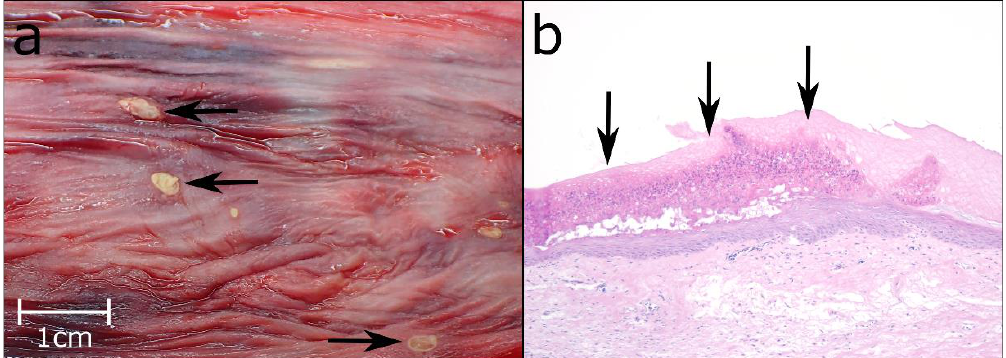
Figure 4. ( a ) Multifocal ulcerations of the oesophageal mucosa (black arrows). ( b ) Pustular lesions in the oesophageal mucosa (black arrows), Hematoxylin&Eosin (HE), 10×.